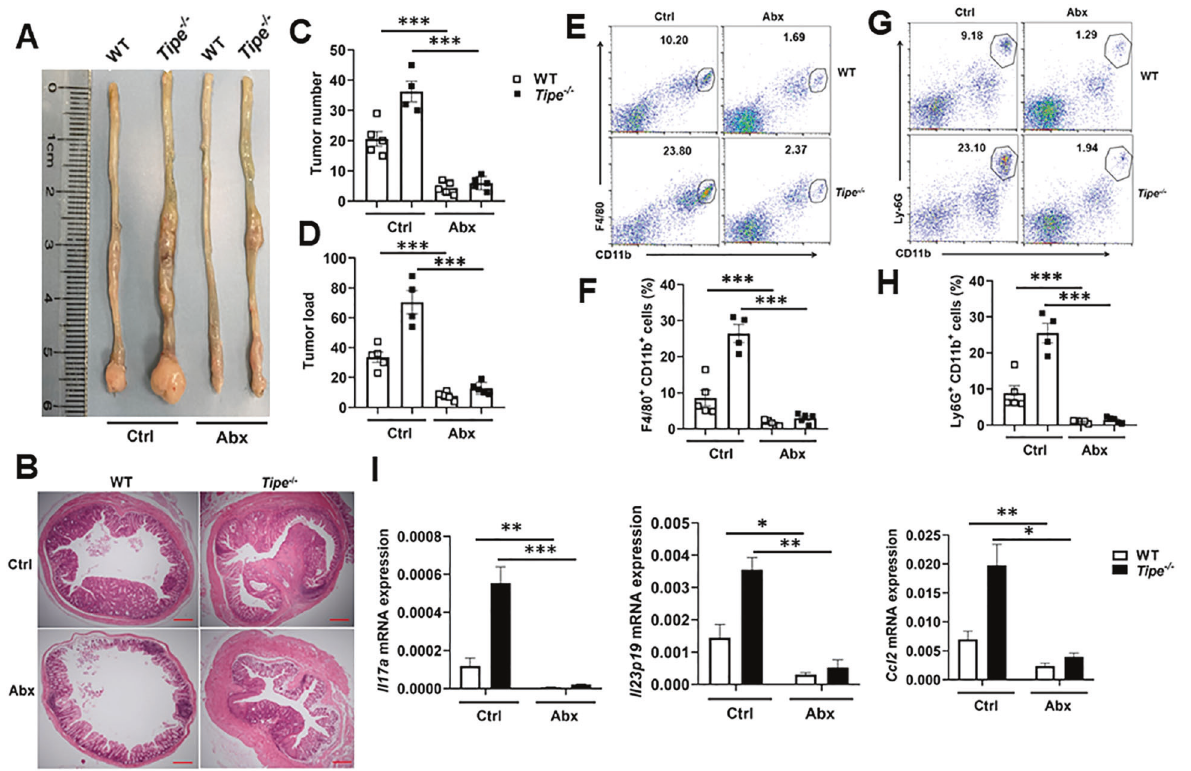
Fig. 5 The microbiota promotes tumor progression in Tipe − / − mice. A , B Representative macroscopic images ( A ) and H&E-stained sections ( B ) of colonic tissue with tumors from WT and Tipe − / − mice treated with antibiotics (Abx) or no antibiotics (Ctrl) on day 90 of the CAC model ( n = 4 or 5 per group). Scale bars, 100 μ m; original magni fi cation ×4. C , D Colon tumor number ( C ) and tumor load ( D ) from WT and Tipe − / − mice as described in ( A ). E , F Flow cytometic dot plot analysis ( E ) and quanti fi cation of CD45 + F4/80 + CD11b + cells ( F ) in colon tumor tissues from WT and Tipe − / − as described in ( A ). G , H Flow cytometic dot plot analysis ( G ) and quanti fi cation of CD45 + Ly-6G + CD11b + cells ( H ) in colon tumor tissues from WT and Tipe − / − mice as described in ( A ). I Quanti fi cation of in fl ammatory genes Il17a , Il22, and ccl2 mRNA expression by quantitative real-time PCR in the colon tumor tissues of WT and Tipe − / − mice treated with Abx or Ctrl on day 90 of the CAC model ( n = 4 or 5 per group). Data are presented as mean ± SEM and are representative of two independent experiments. Student ’ s t test ( C , D , F , H , I ), * p < 0.05, ** p < 0.01, *** p <